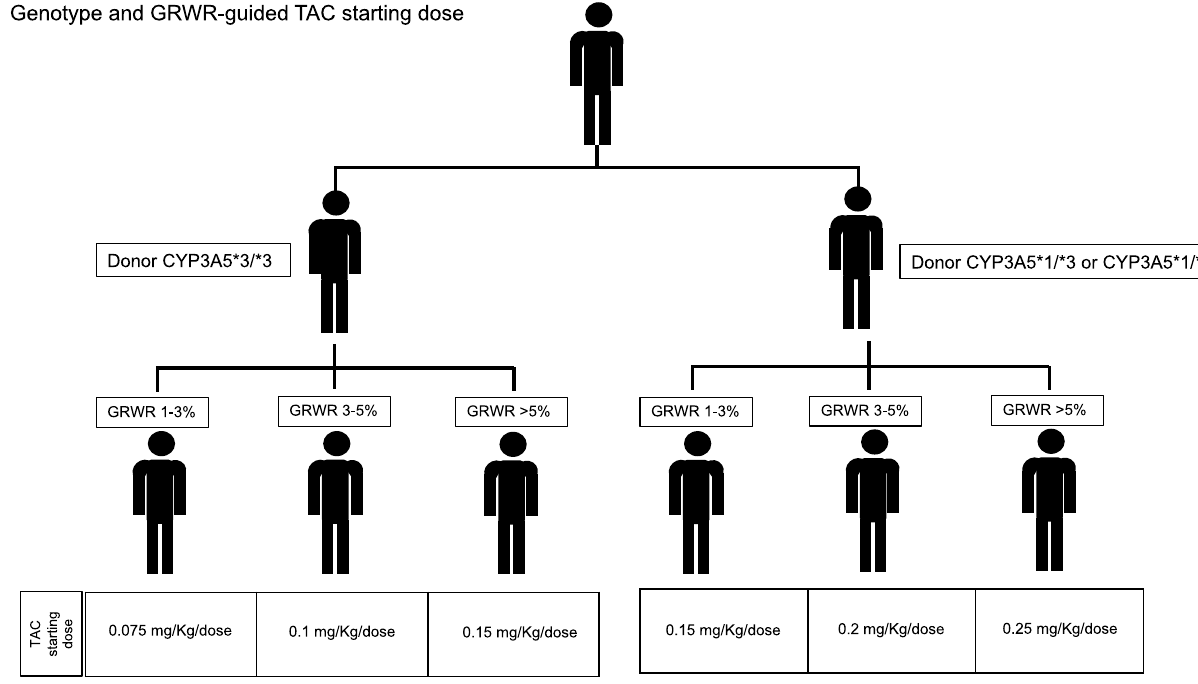
Figure 3. Proposal for an algorithm for a genotype and GRWR guided TAC starting dose. TAC, tacrolimus; GRWR, Graft-to-Recipient Weight